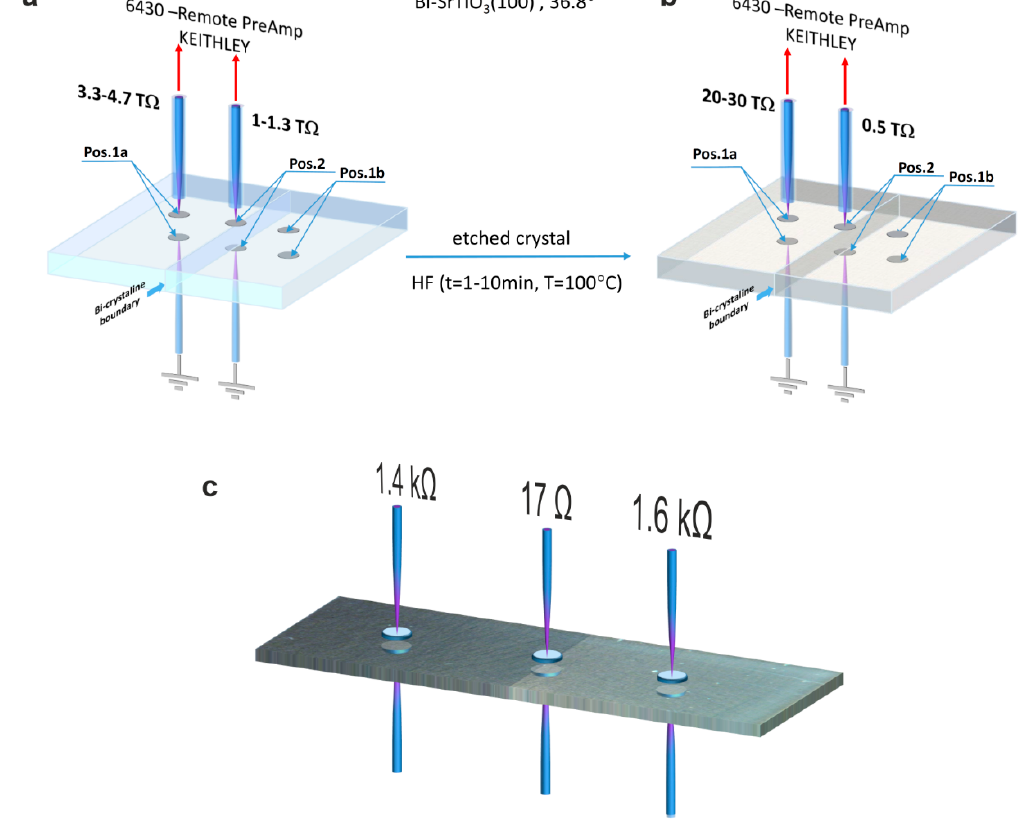
Figure 6. Investigation of macroscopic electronic transport properties. The resistance was measured at three different positions of the as-received bicrystal ( a ), the etched bicrystal ( b ) and the thermally-reduced bicrystal ( c ). The illustration in ( c ) is based on a microscopic image of the sample showing the non-uniform color change upon reduction.